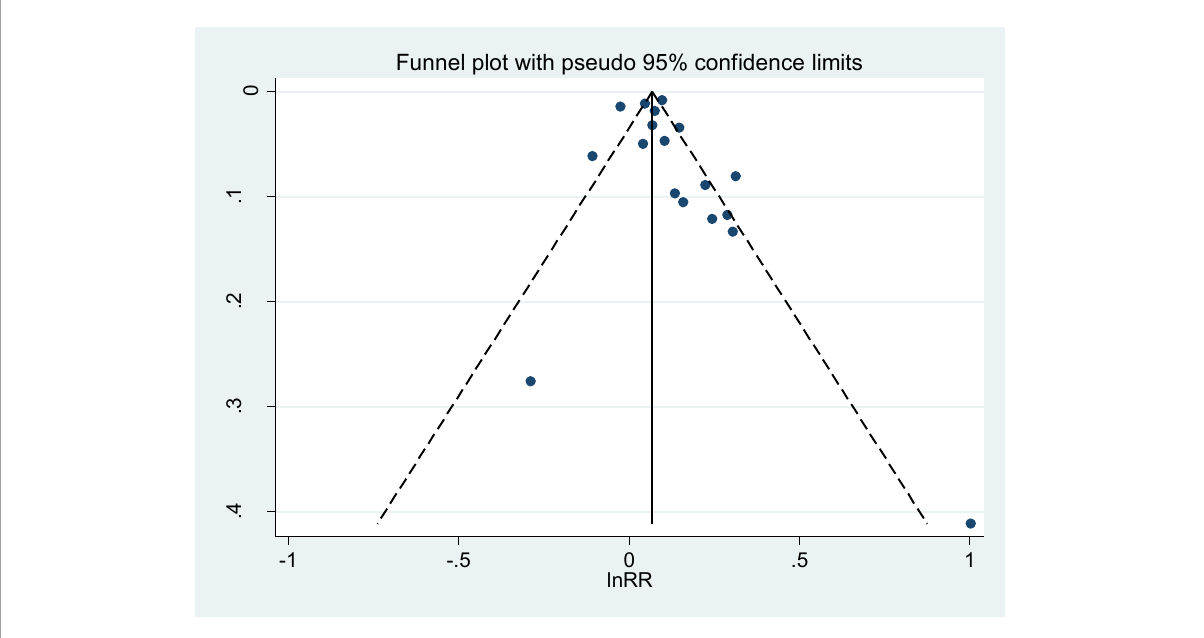
FIGURE3 Funnel plot for studies of screen time in relation to the risk of